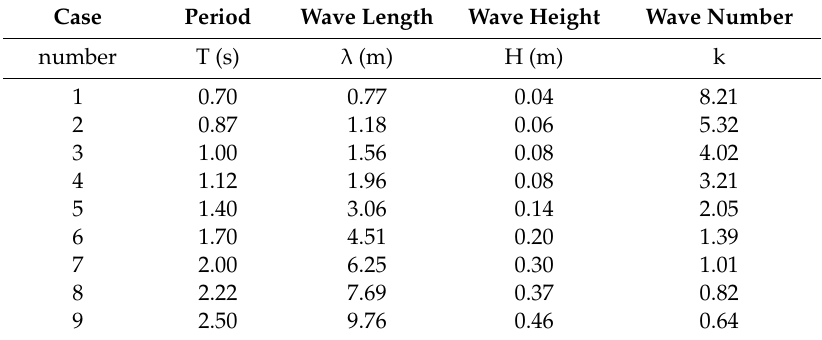
Table 2. Specifications for the simulation